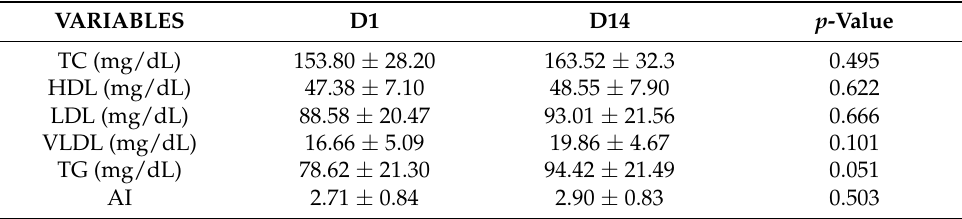
Table 2. Lipid profile.